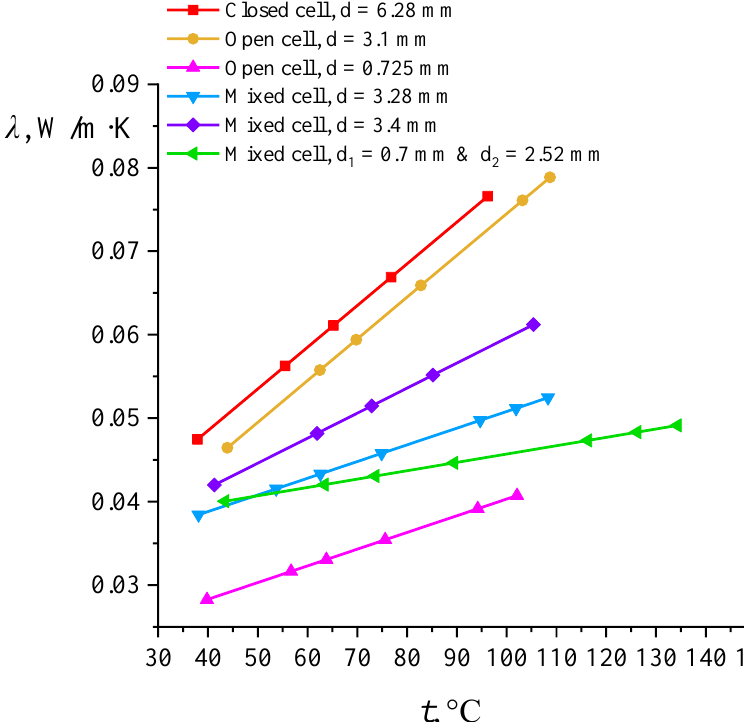
Figure 5. Thermal conductivity of polyurethane foam samples as a function of temperature in the case when the heater is located below.